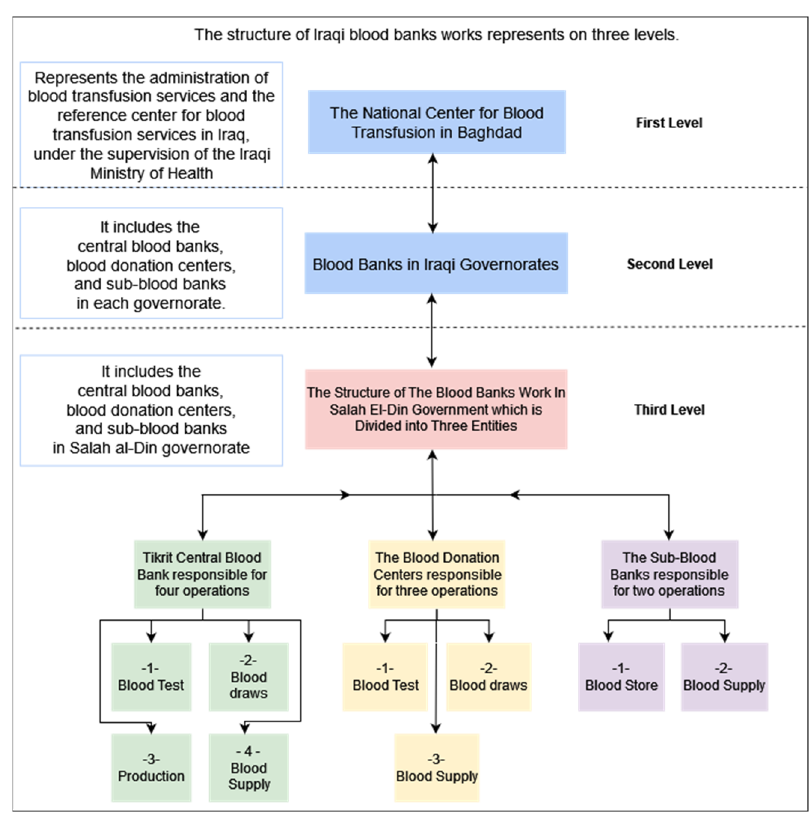
Figure 1. The structure of the blood bank work in Iraq.